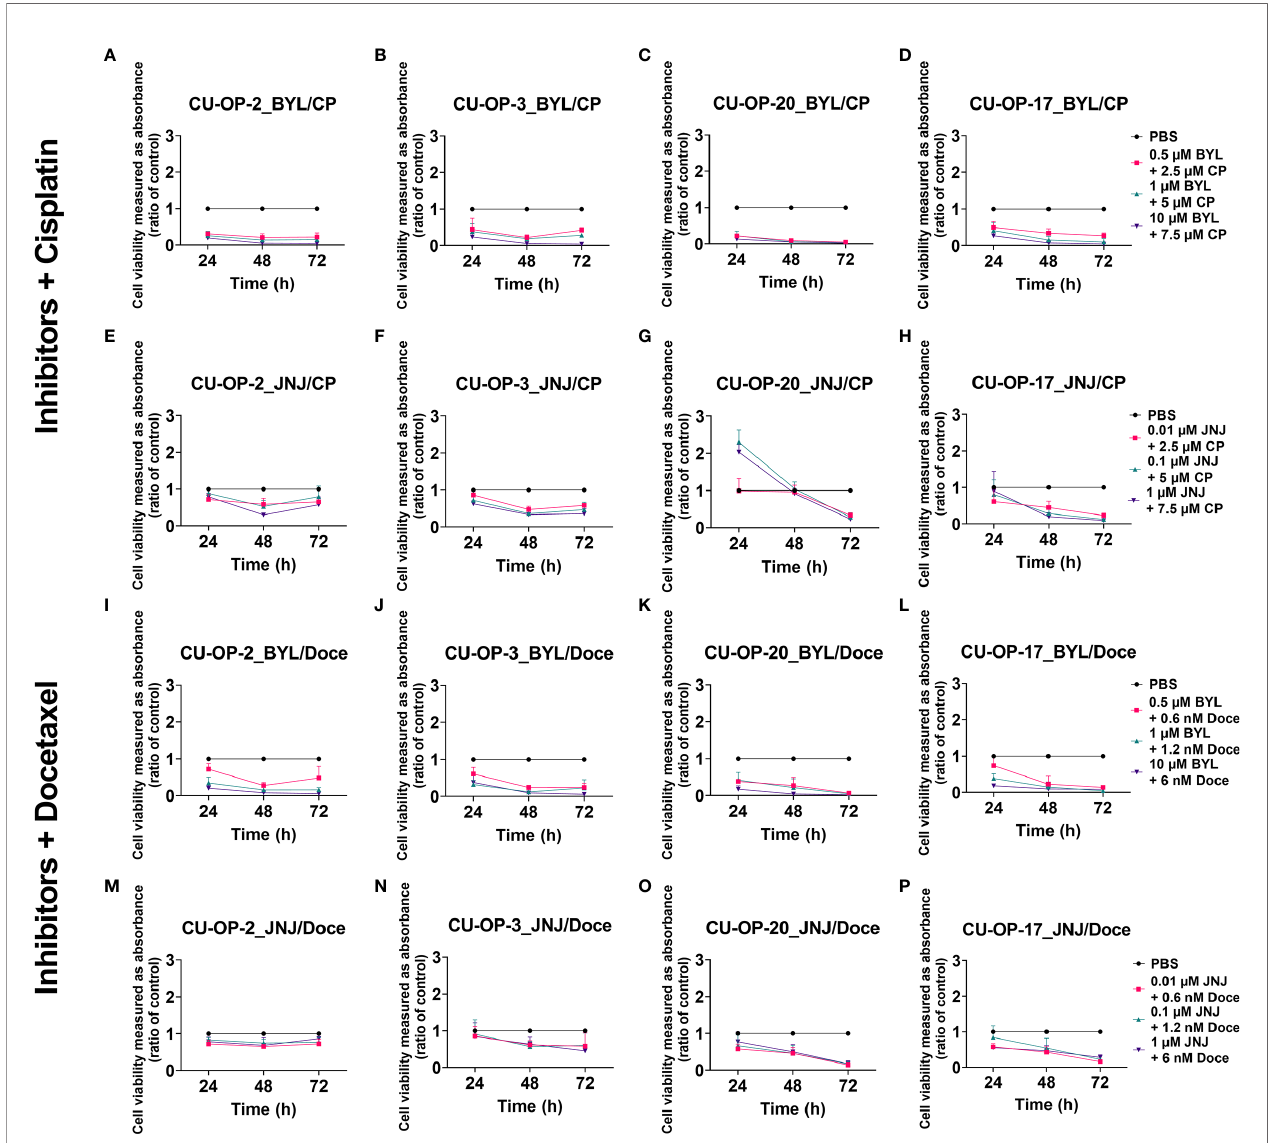
FIGURE 5 | WST-1 viability assays evaluating cellular metabolic capacity by absorbance on HPV + CU-OP-2, -3, -20, and HPV - CU-OP-17 cell lines upon treatment with BYL719 or JNJ-42756493 with cisplatin and docetaxel. WST-1 viability assays measuring absorbance following treatment for 24, 48 and 72 h of HPV + CU-OP- 2, -3, -20 and HPV - CU-OP-17 with cisplatin together with BYL719 (A – D) or JNJ-42756493 (E – H) resp., as well as docetaxel together with BYL719 (I – L) or JNJ- 42756493 (M – P) resp. The graphs represent three experimental runs per cell line, and the data are presented with the mean ± standard deviation. CP denotes cisplatin; DOCE denotes docetaxel; BYL denotes BYL719; JNJ denotes